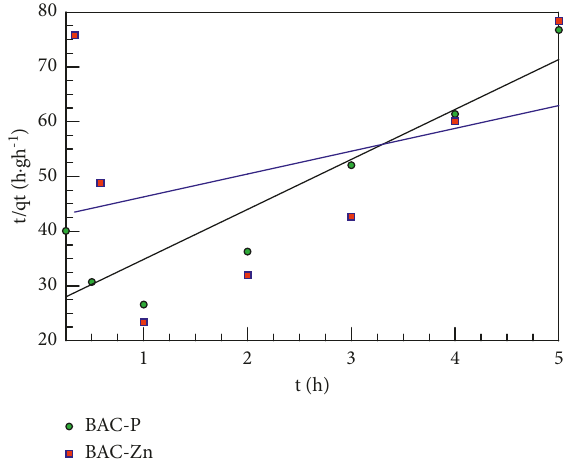
Figure 16: Pseudo-second-order kinetics for adsorption of 1 g L − 1 Cu(II) ions onto the BAC-P and BAC-Zn